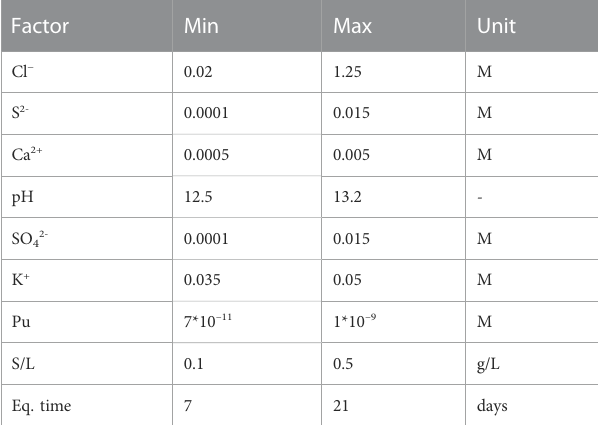
TABLE 2 Boundary values for nine factors identi fi ed for factorial design (screening).